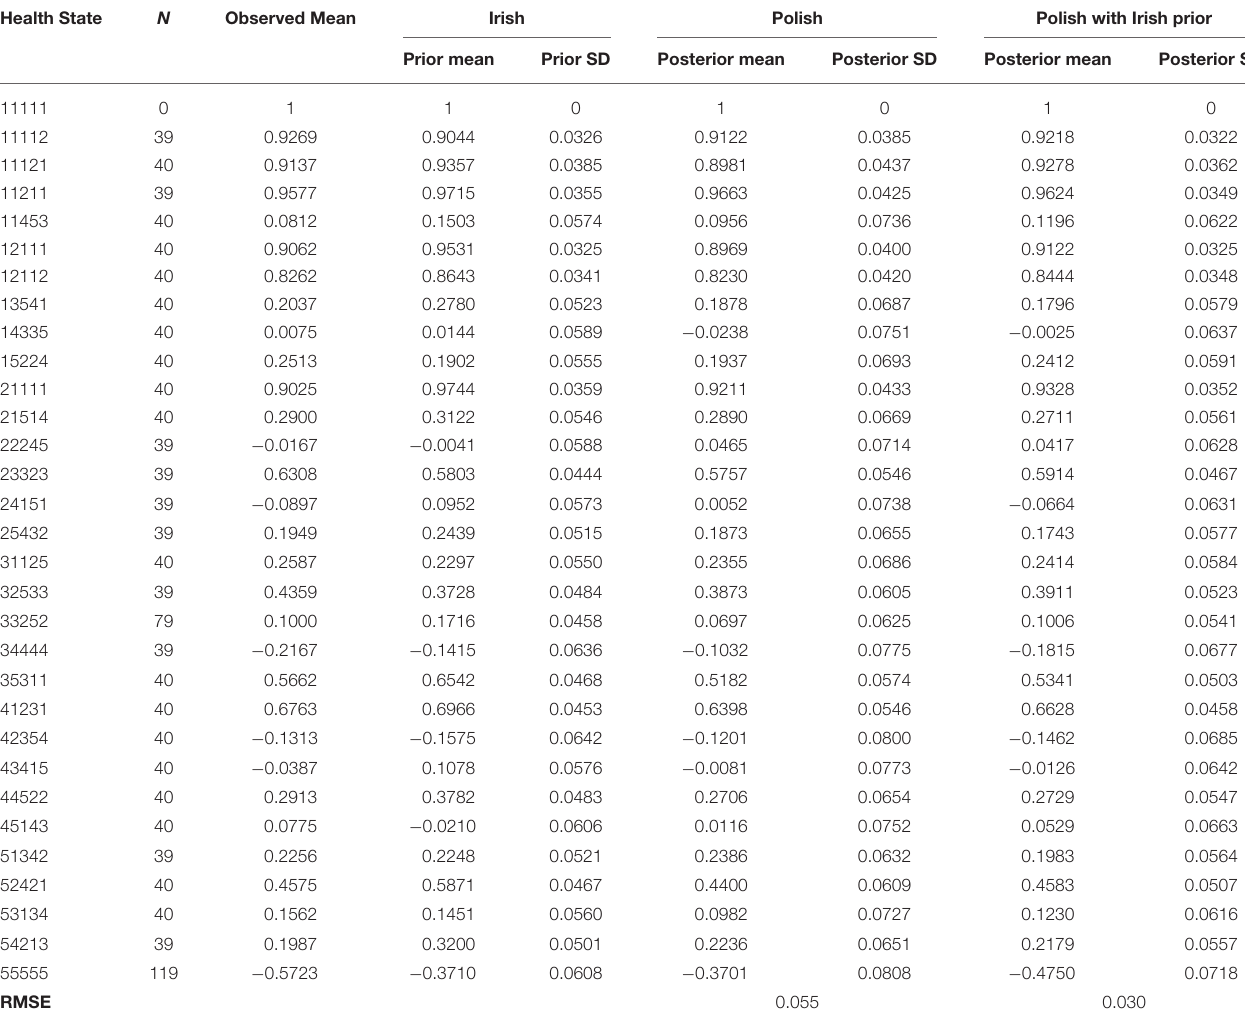
TABLE 2 | Estimates for utilities of the 30 EQ-5D-5L health states valued in the survey in addition to the full health. Health